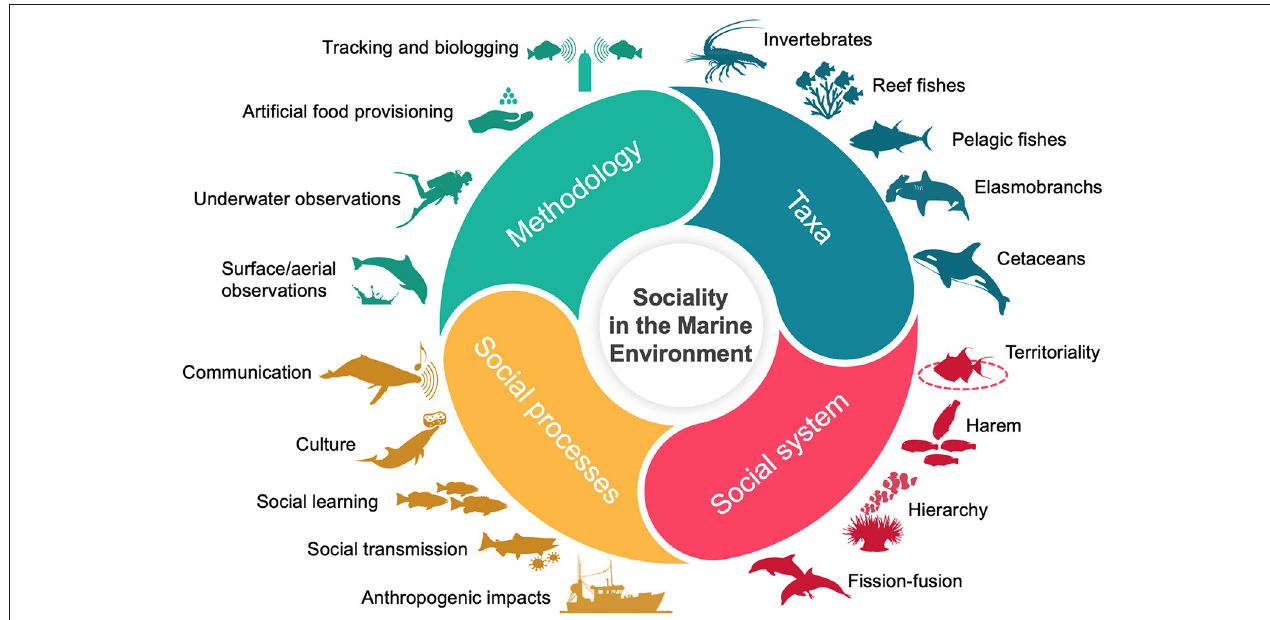
FIGURE 1 | The diversity of sociality in marine species. This RT collates papers from a broad range of species, with different social systems that occupy diverse habitat types. There is an emphasis on the technological and analytical developments required to explore the implications of sociality in the context of ecology, evolution, and conservation within an environment that is increasingly impacted by human